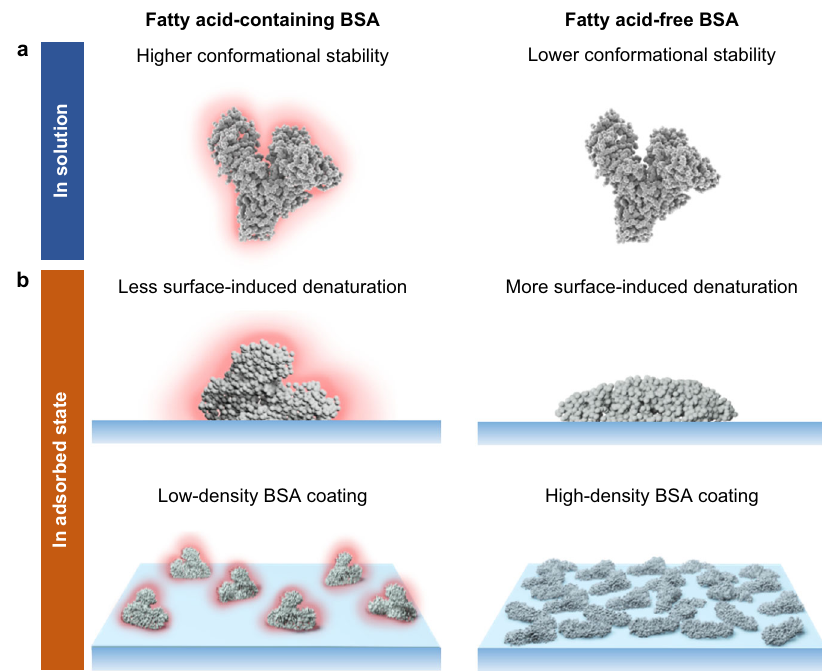
Fig. 6 Effect of fatty acid stabilizers on BSA conformational and adsorption properties and implications for antifouling coatings. a Schematic illustration of fatted and defatted BSA protein molecules in solution. b Schematic illustration of fatted and defatted BSA protein molecules in the adsorbed state. Higher conformational stability and charge repulsion of fatted BSA leads to less adsorption-induced denaturation, greater protein-protein repulsion, and thus less tightly packed protein coatings. Conversely, the lower conformational stability and charge repulsion of defatted BSA leads to greater adsorption-induced denaturation, less protein-protein repulsion, and thus more tightly packed protein coatings. As a result, defatted BSA proteins form superior antifouling